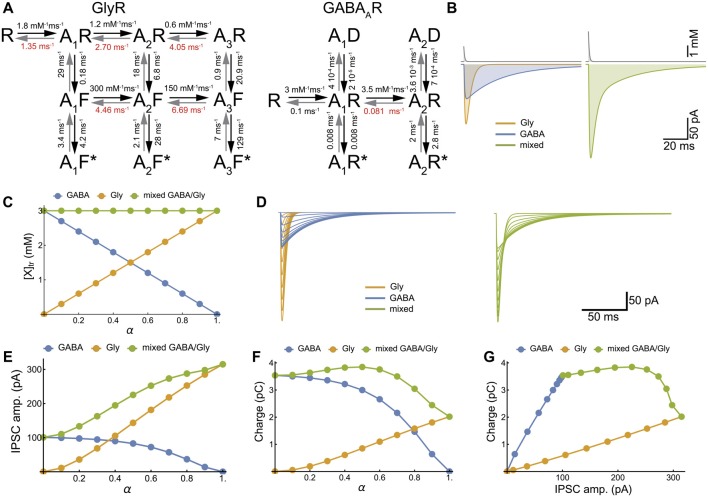
Model of cotransmission shows that swapping glycine for GABA in the neurotransmitter transient maintains the strength of synaptic inhibition. (A) Kinetic schemes for the activation of GlyR (Burzomato et al., 2004) and GABAAR (Jones and Westbrook, 1995; Labrakakis et al., 2014) that were used for the numerical simulations. We adopted the set of rate constants determined by Burzomato et al. (2004) and Labrakakis et al. (2014); with the exception of the dissociation rate constants, indicated in red, that were adjusted for matching the time course of our recorded mIPSCs (τ = 6.4 ms and 34.3 ms for glycine and GABA IPSC respectively). (B) Numerical simulations of the mIPSCs evoked by concentration transient (1.5 mM) of glycine or GABA applied alone (left) or together (right). The concentration scale is the total concentration of neurotransmitter. (C) Inverse relationships of GABA and glycine concentrations for increasing values of α, which is the fraction of glycine released during each transient, assuming constant vesicular release (3 mM). (D–G) Numerical simulations of glycinergic, GABAergic and mixed mIPSCs when α increased from 0 to 1 by increments of 0.1, showing the current traces (D), the IPSC peak amplitudes (E), the IPSC charge transfer (F) and the IPSC charge-amplitude relationships (G).